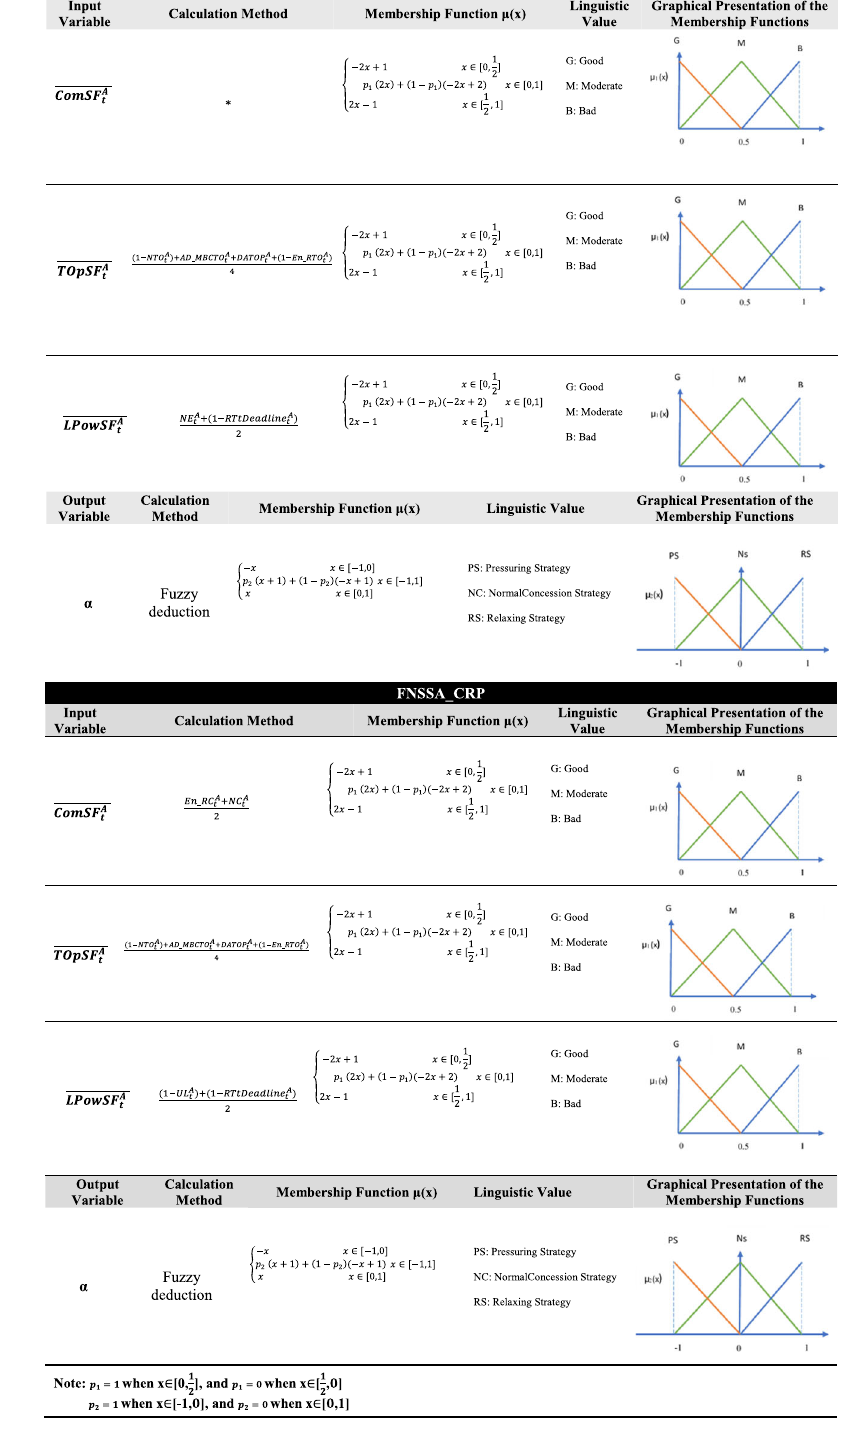
Table 2 Calculation methods, membership functions, linguistic values and graphical presentations of the membership functions of the inputs and output of FNSSDS from perspectives of both CRB and